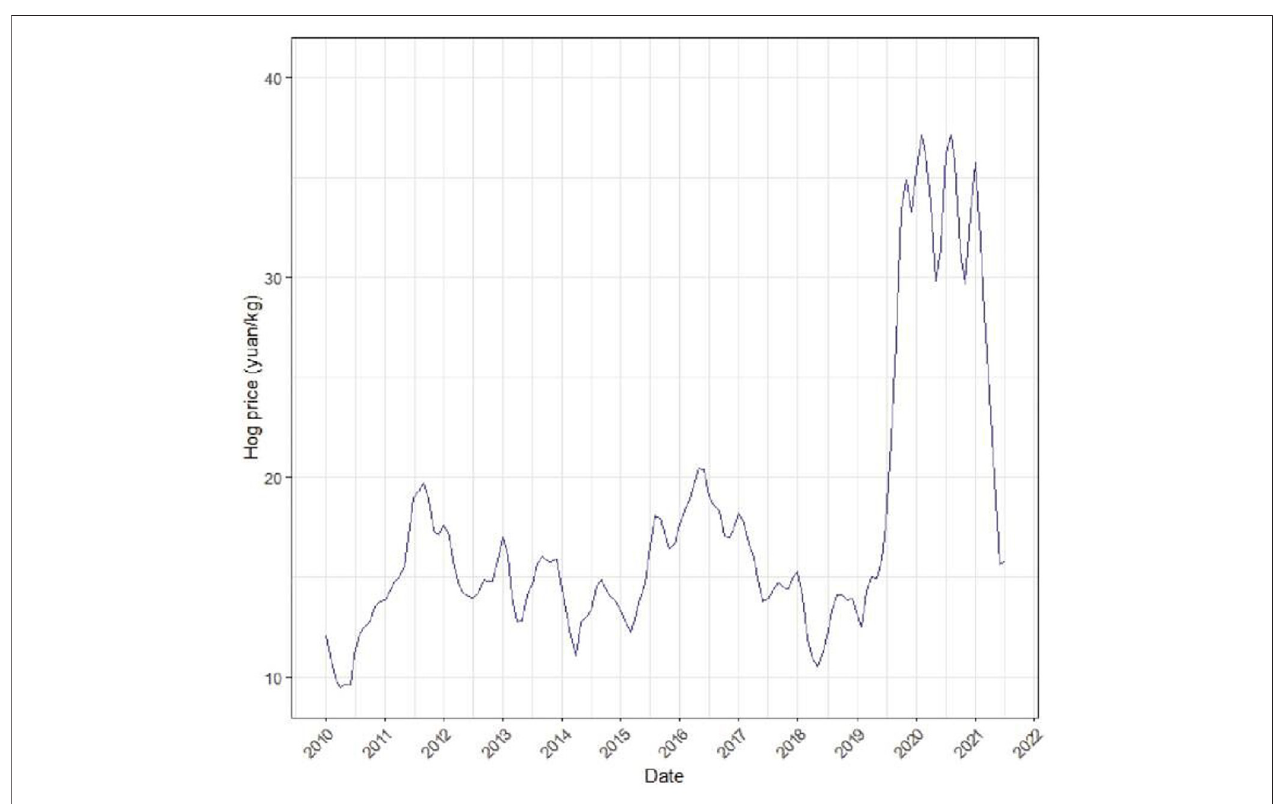
FIGURE 1 | Price trend of hog (from January 2010 to July 2021)